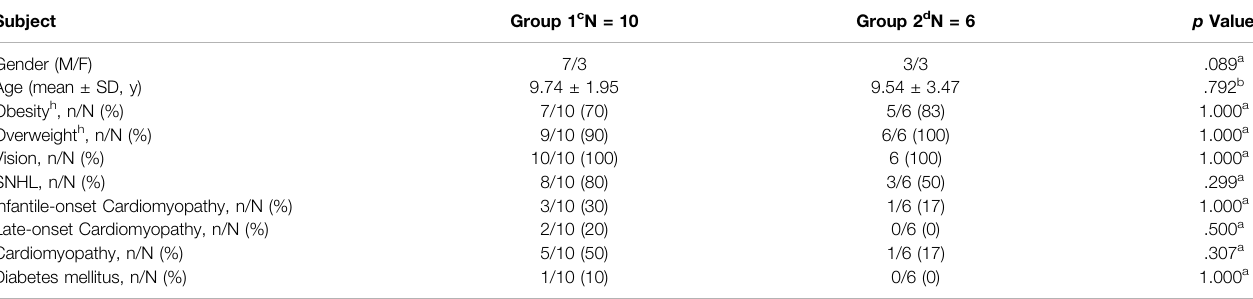
TABLE 7 | Comparison analysis between ALMS patients who could identify the rose odor and those could